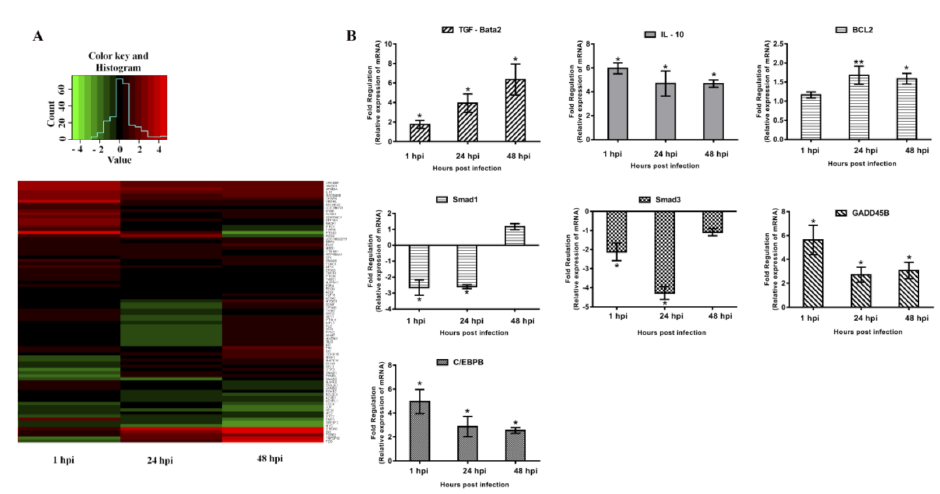
Figure 2. Gene expression patterns. Sixty-three target genes involved in the TGF- β signaling pathway were differentially expressed and were significantly different between PCV2-infected and control PAMs ( A ). Differentially expressed genes at each time point ( B ). Green: negative fold change level. Red: positive fold change level. Fold change was obtained by comparing the relative mRNA expression of target genes in PCV2-infected and uninfected control PAMs. Results are representative of three independent experiments and are presented as mean ± SE. ** represents p <0.01, * represents p < 0.05. Table 1. Differentially expressed TGF- β target genes ( p < 0.05 and absolute fold change ≥ 1.5) between PCV2-infected and mock-infected control. Numbers in bold denote significant differential